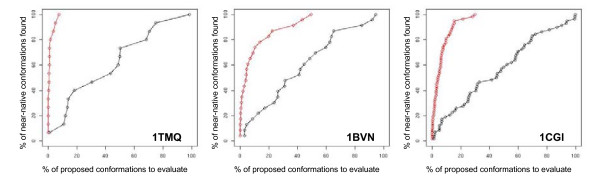
Enrichment curves for [PDB:1BVN], [PDB:1CGI] and [PDB:1TMQ]. It is shown how many percent of the dataset must be evaluated until which percent value of all near-native (RMSiCα<5Å) are found. (X-axis: Percentage of dataset, Y-axis: Percentage of near-native solutions found). The black line shows the results for the ranking due to the 'classical' geometric correlation and the red line is obtained by the recalculation using the optimised values. (100% equal for 1BVN 23 near-native structures, for 1CGI 58 and for 1TMQ 15).